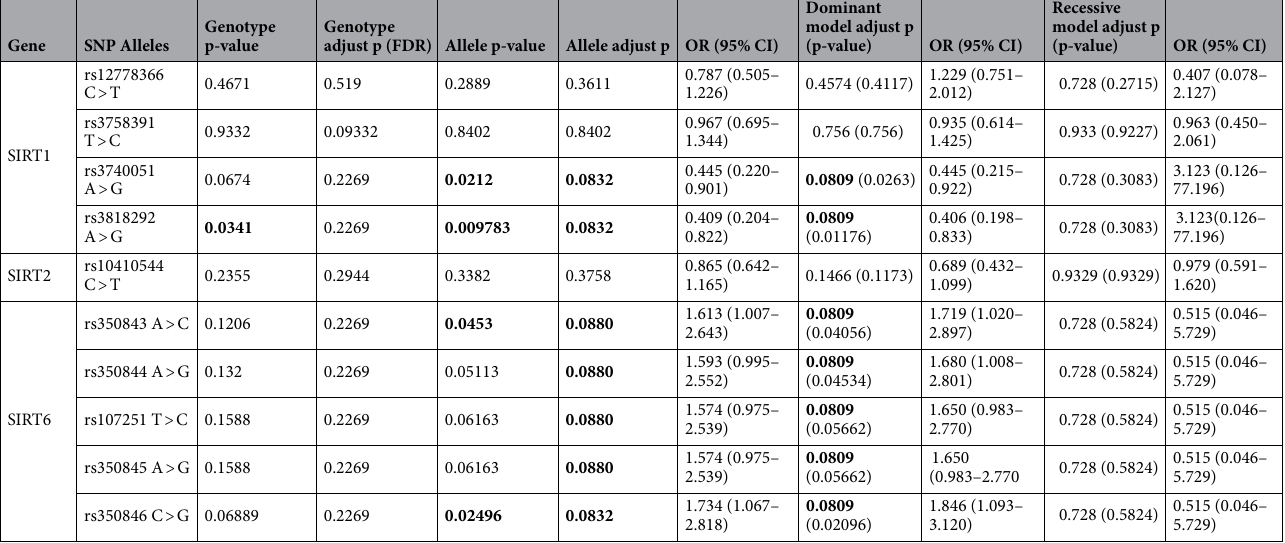
Table 1. Statistical results of the investigated SNP. OR odds ratio, CI confidence interval. Marginal associations with PD risk are indicated in bold.